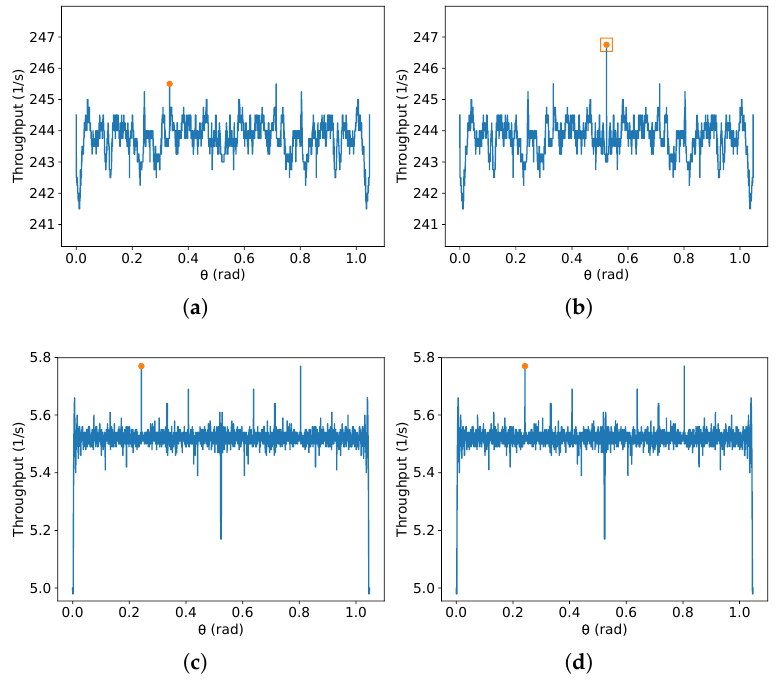
Figure 11. Continuation of Figure 10: examples similar to Figures 8 and 9 but using 10 7 and 10 7 + 1 equally spaced points for θ ∈ [0, π / 3). ( a ) For 10 7 samples, T = 4 s, s = 2 m and d = 0.13 m. ( b ) For 10 7 + 1 samples, T = 4 s, s = 2 m and d = 0.13 m. ( c ) For 10 7 samples, T = 100 s, s = 2.40513 m and d = 1 m. ( d ) For 10 7 + 1 samples, T = 100 s, s = 2.40513 m and d = 1